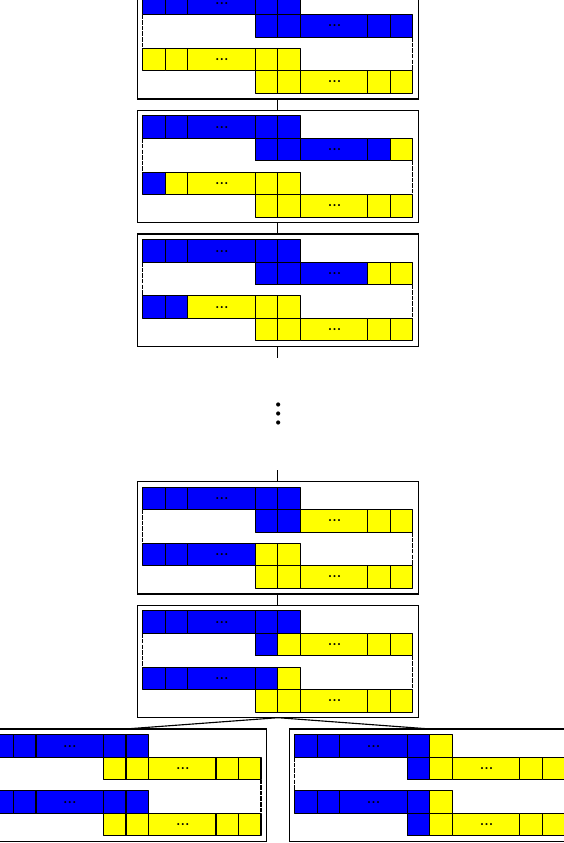
Figure 9. The tree of (cid:13)op transitions of (cid:13)avor-equivalence classes, and thus also of the descendant gauge theories, starting from Sp( N )+ N f F . The tree structure is identical for the (cid:13)avor-equivalence classes for E 7 + N 56 56 , as they both have a special orthogonal group as (cid:13)avor group.